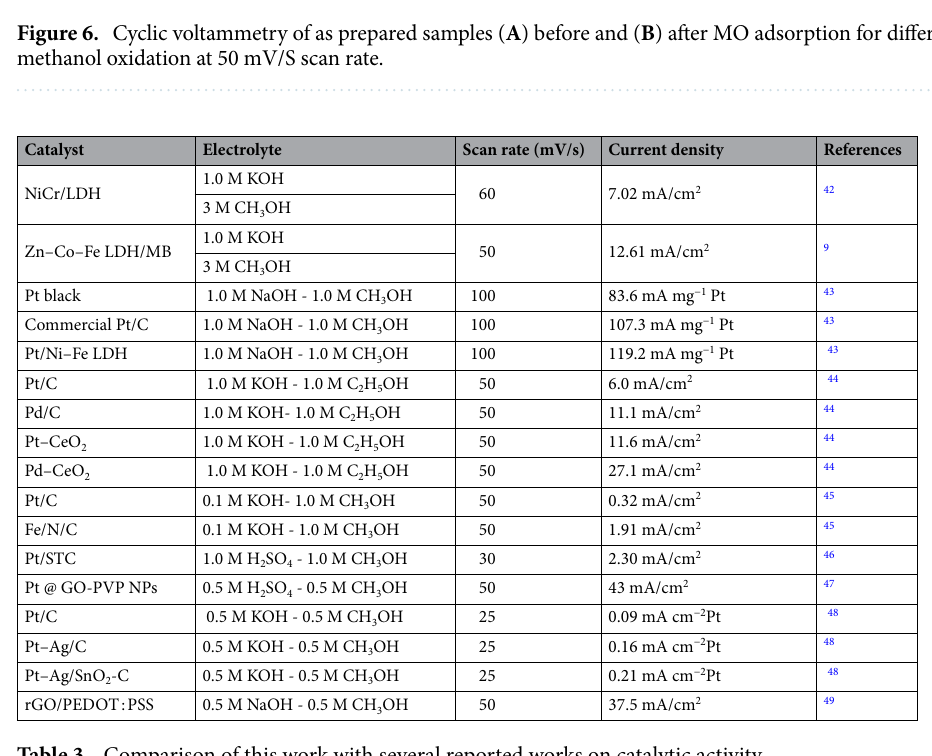
Table 3. Comparison of this work with several reported works on catalytic activity.